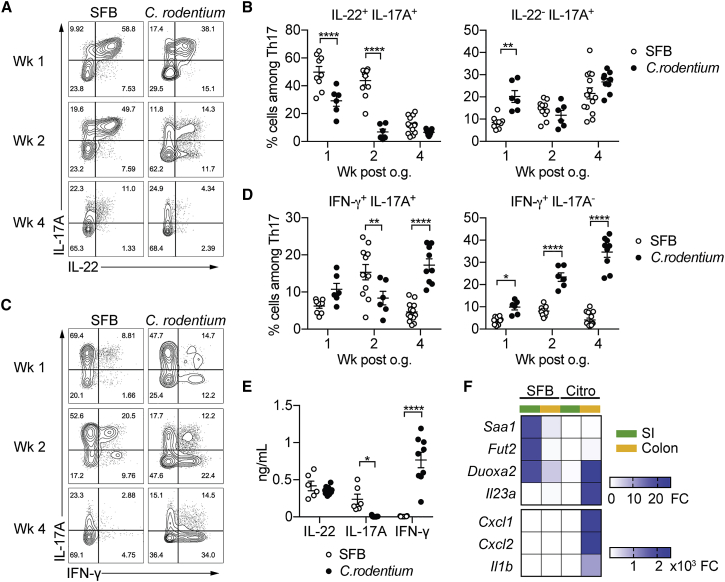
SFB- and C.-rodentium-Elicited Th17 Cells Have Different Cytokine Profiles(A–D) Representative intracellular staining for IL-17A and IL-22 (A) or IFN-γ (C) and corresponding quantifications in (B) and (D) in Th17 cells from the SI of mice colonized with SFB and colon of mice infected with C. rodentium at 1 (n = 9 and 6), 2 (n = 11 and 6), and 4 (n = 14 and 9) weeks after gavage. Lamina propria cells were isolated at the indicated time point, re-stimulated with PMA and ionomycin and Brefeldin A for 2 h, and analyzed by FACS. Bars show the mean ± SEM for the indicated populations, and each symbol represents an individual mouse from two pooled independent experiments.(E) Cytokine concentration in supernatants of FACS-purified Th17 cells from the SI of mice colonized with SFB or colon of mice infected with C. rodentium. In the graphs, bars show the mean ± SEM, and each symbol represents a technical replicate. Cells were FACS-purified from one sample per group, obtained by pooling 3–6 mice. Results are representative of three independent experiments.(F) Fold-change (FC) induction of listed genes quantified by qPCR in the SI (green) and colon (orange) of mice colonized with SFB or infected with C. rodentium, 1 week after gavage. Fold change is calculated on the matching organs from untreated mice and gene expression is normalized against β-2-microglobulin. Data are from two pooled independent experiments. ∗p < 0.05, ∗∗p < 0.01, ∗∗∗∗p < 0.0001 by two-way ANOVA with Sidak’s post-test. Please see also Figure S2.